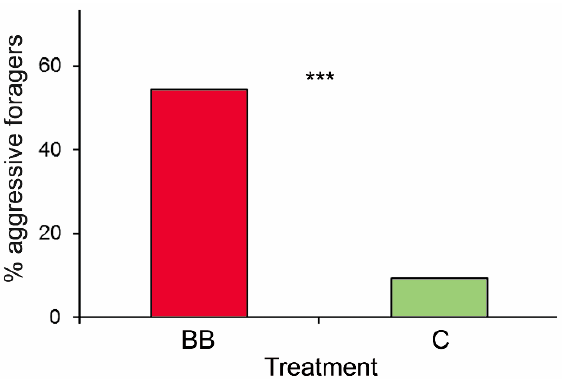
Figure 3. The percentage of Lasius fuliginosus aphid milkers demonstrating aggressive reactions during their first encounter with Chaitophorus populeti aphids contaminated with Beauveria bassiana (BB) or uncontaminated control aphids (C). Generalized Linear Model (GLM), with binomial distribution: *** p < 0.0001.